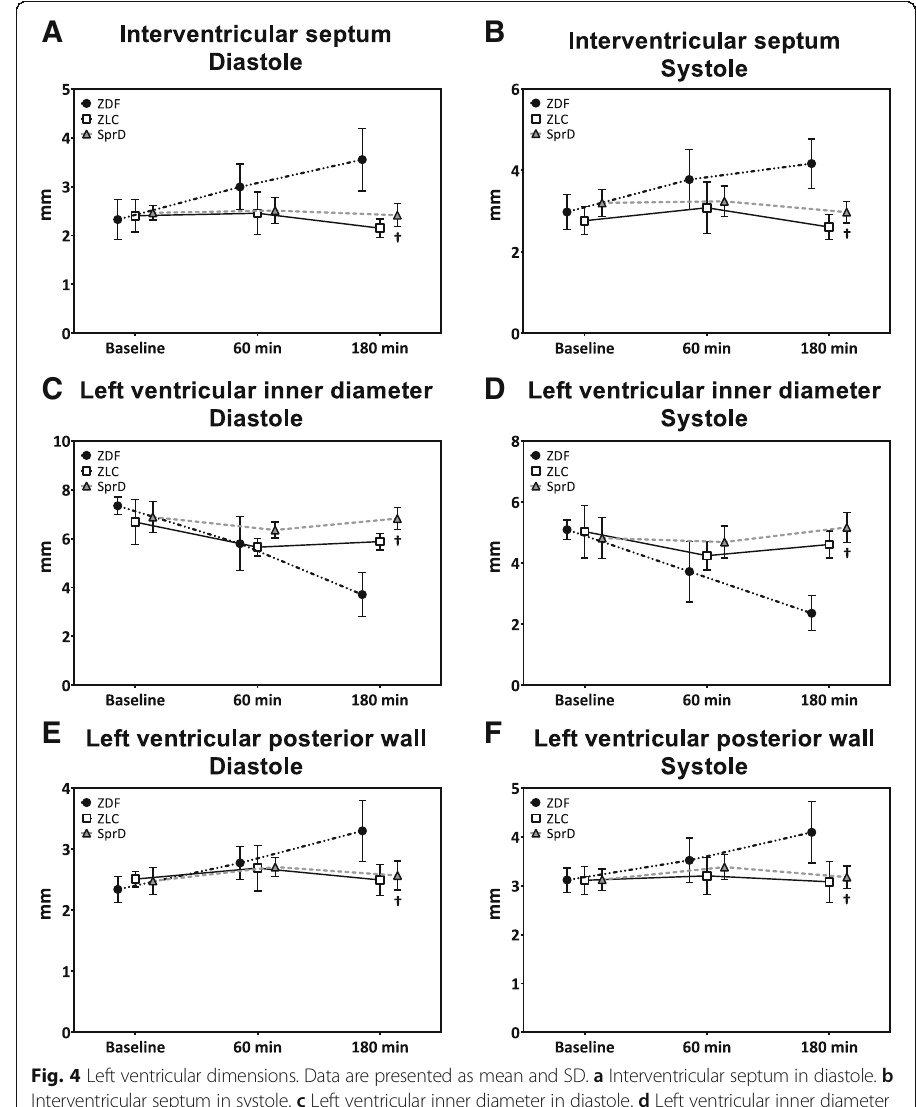
Fig. 4 Left ventricular dimensions. Data are presented as mean and SD. a Interventricular septum in diastole. b Interventricular septum in systole. c Left ventricular inner diameter in diastole. d Left ventricular inner diameter in systole. e Left ventricular posterior wall in diastole. f Left ventricular posterior wall in systole. Number of animals at examination times: ZDF ( n =11, 11, and 10), ZLC ( n =14, 6, and 5), and SprD ( n =8 at all examinations). † p <0.05 ZDF vs. SprD. ZDF: Zucker diabetic fatty group, ZLC: Zucker lean control group, SprD: Sprague Dawley